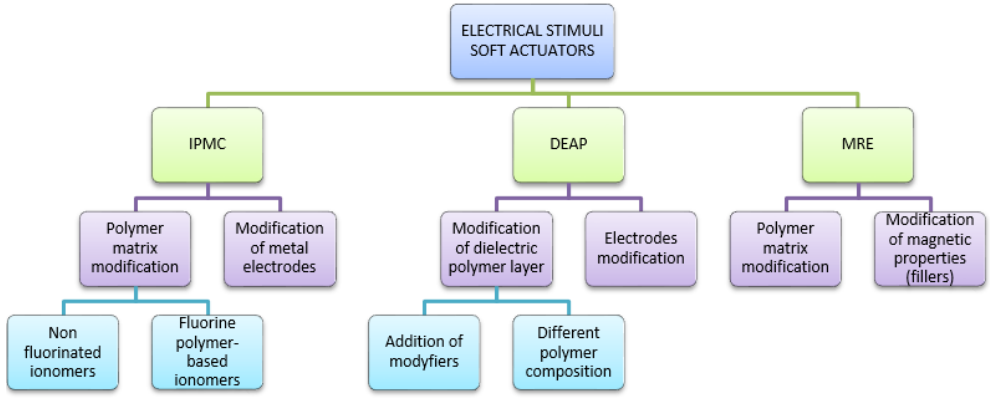
Figure 1. Recent trends in modification of electrical stimuli soft